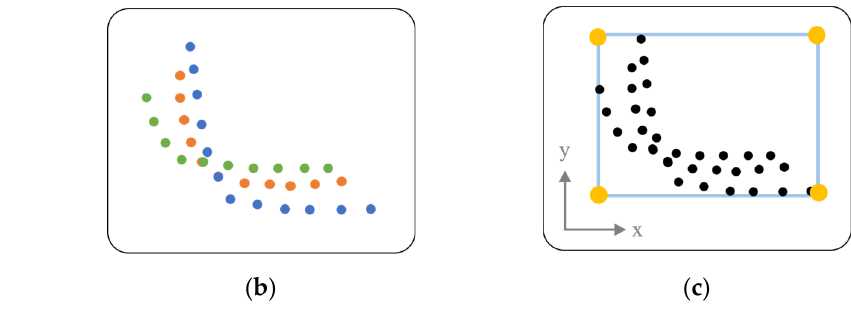
Figure 2. Multi-layer clustering: ( a ) classification of data that recognize the same obstacle in each layer, and 3 single layers that recognize the same obstacle are shown in 3D; ( b ) representation of all 3D data on a 2D plane; ( c ) representation as square data for data simplification.